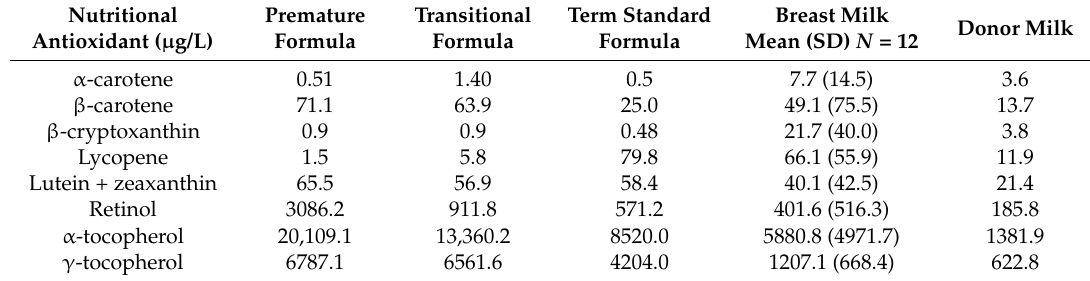
Table 1. Nutrition antioxidant content of infant feedings.